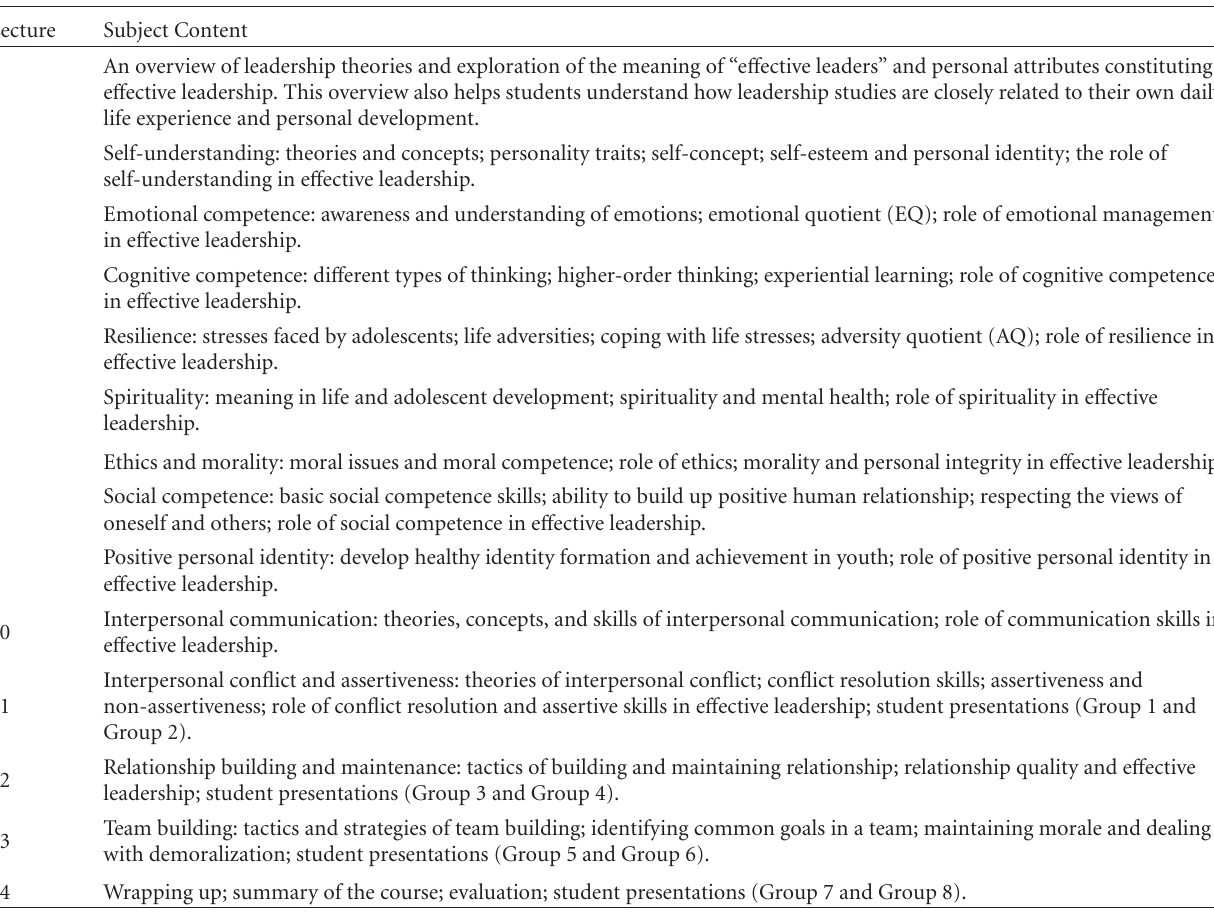
Table 5: Topics covered in di ff erent